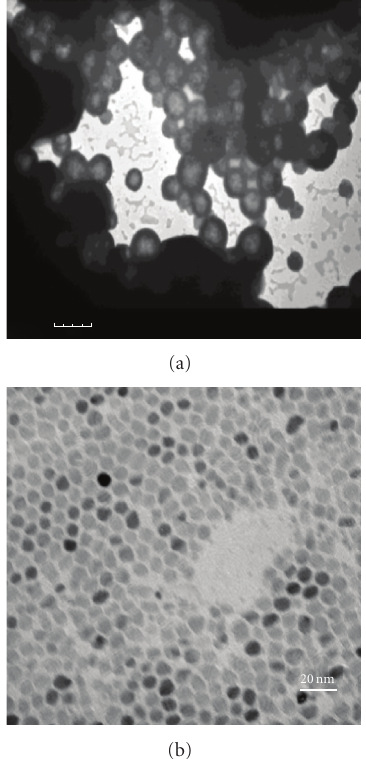
Figure 3: TEM images of Magnato-optical nanocomposite (mag- netite-gold core shell nanocompostite) and is found to be (a) 15 nm, (b) 1.1 nm for the spherical gold nanoparticles, and core shell.